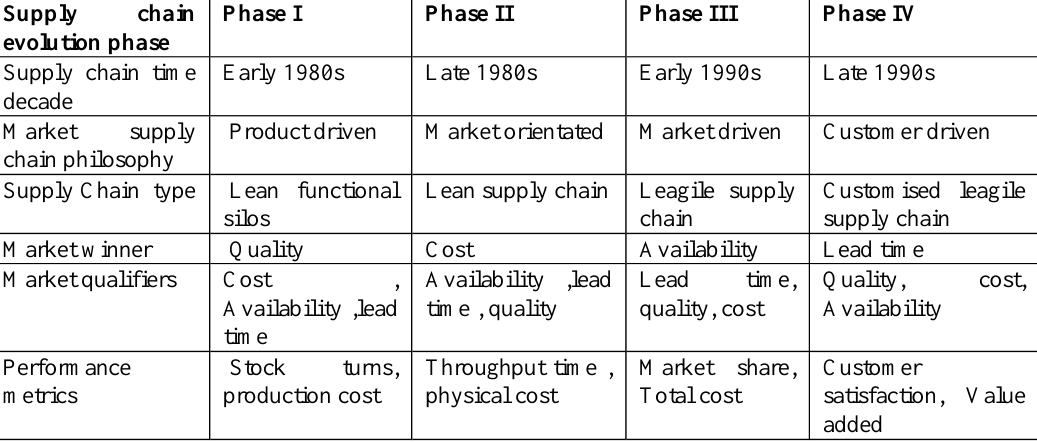
Table A1. Migratory model summarising the transition in PC supply chain